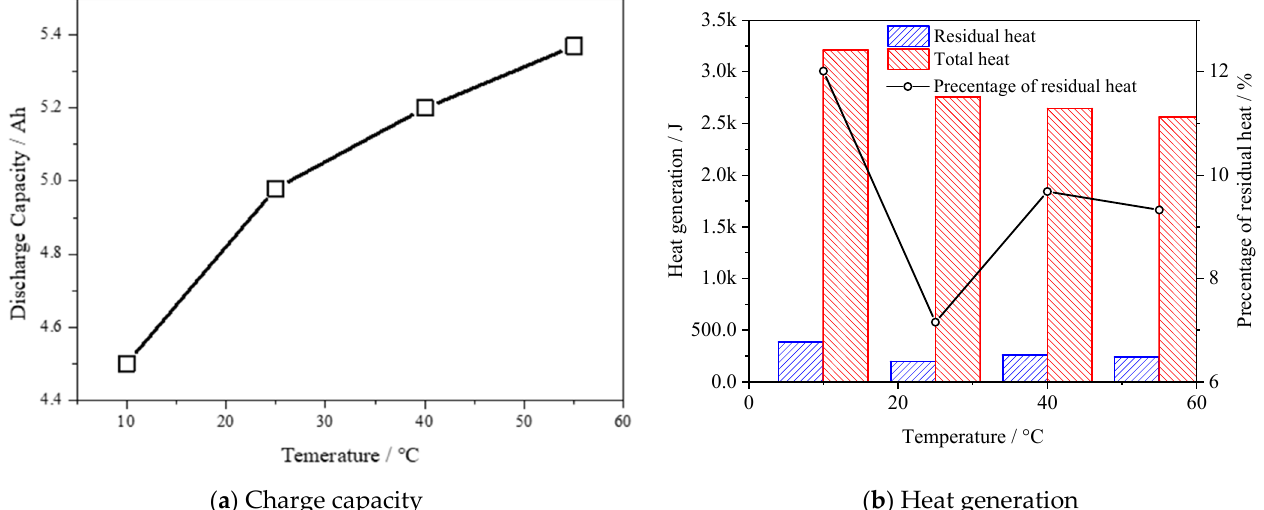
Figure 10. Effect of ambient temperature on the battery during the discharge stage.